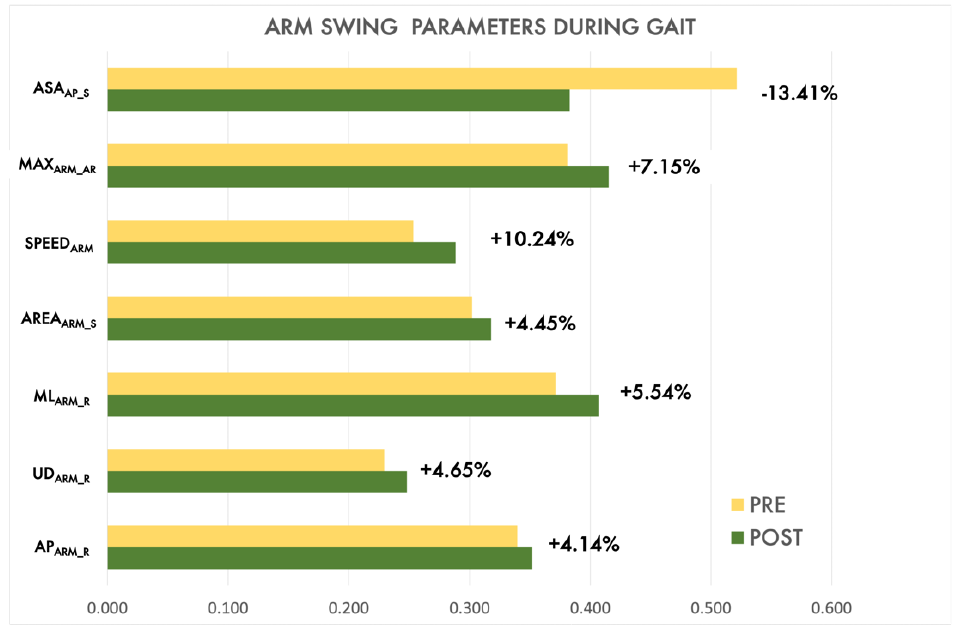
Figure 9. Normalized bar plots comparison of arm swing features (G task) between PRE and POST sessions by the PD group, after executing Lateral Weightlifting and Frontal Weightlifting.